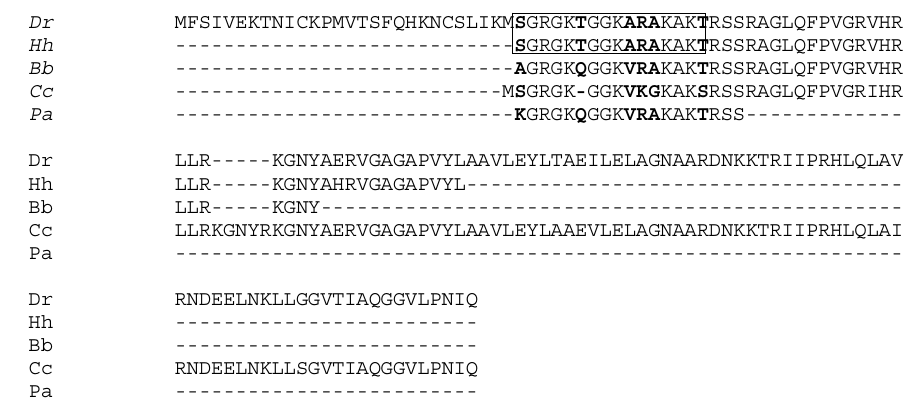
Figure 3. The deduced amino acid sequence of zebrafish parasin I was aligned with those of hipposin, buforin, scallop (from H2A histome) and parasin. The different residues are bolded. The box indicates the high conservation of the amino acid sequence in zebrafish parasin and hipposin. Hh, Hippoglossus hyppoglossus ; Bb, Bufo bufo ; Cc Cyprinus carpio , Pa, Parasilurus asotus ; Dr, Danio rerio Cat-D, a protease that could be responsible for production of Parasin I from histone H2A, was also identified in zebrafish (zfCat-D). zfCat-D showed similarity to an eukaryotic lysosomal aspartic protease (Table 2) and BLAST analysis indicated that zfCat-D displays a conserved motif, many eukaryotic endo-peptidase, can be identified (Figure 4). Figure 4. The first 57 N-terminus residues, deduced from CatDcDNA of zebrafish, is aligned with those of Mp ( Macroscelide sproboscideus ), Ch ( Clupeaharengus ), Rt (Rainbow trout, Oncorinchus mikissis ) and Tarku ( Takifugu rubripes, Tf). The typical motifs (signal peptide, A1 propetide, and mature protein) are indicated. Analysis of the amino acid sequence of zfBPI indicated that this protein shows a significant identity with other members of BPI family (Table 2). In particular, the sequence of zfBPI shows a possible functional domain in the N-terminal region (residues 59–118) similar to the lipopolysaccharide(LPS)-binding domain found in human, carp and trout BPI proteins (Figure 5). Figure 5. Alignment of the predicted lipopolysaccharide(LPS)-binding domain (LPD) of zebrafish (Dr; Danio rerio ) BPI/LDP with that of rainbow trout, LBP/BPI-1 and -2, human, and carp. Identical and similar amino acid residues are indicated by asterisks (*) and colon (:), respectively. Bars (–) indicate gaps that are introduced for optimal alignment. The number at the end of each sequence represents amino acid identities (%) to zebrafish BPI/LBD. The positive charged amino acid residues (K or R) conserved in BPI/LPD of carp (Cc; Cyprinus carpio) , rainbow trout (Om1,2; Oncorinchus mikissis ), human (Hs, Homo sapiens ) are indicated by shaded region. Signal peptide